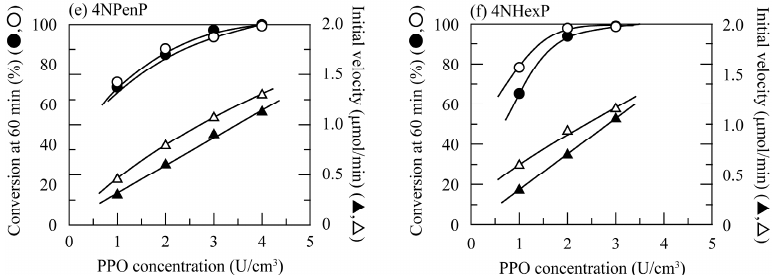
Figure 1. Changes in the conversion percent value at 60 min (circle) and the initial velocity (triangle) with the polyphenol oxidase (PPO) concentration for PPO-catalyzed quinone oxidation of ( a ) p -cresol, ( b ) 4EP, ( c ) 4NProP, ( d ) 4NBP, ( e ) 4NPenP, and ( f ) 4NHexP at pH 7.0 and 40 ◦ C in the presence (open) or absence (shaded) of chitosan beads at 0.10 cm 3 /cm 3 .